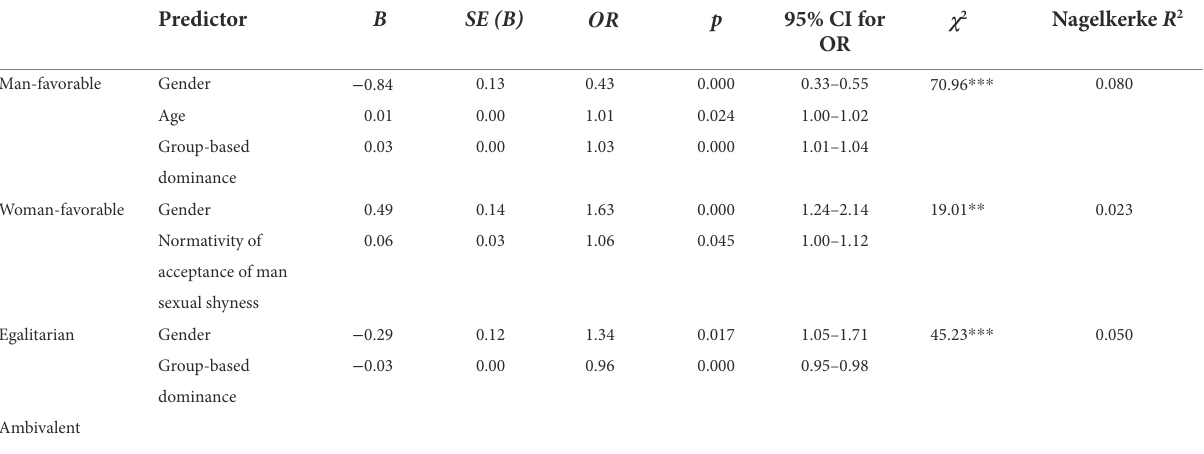
TABLE 7 Hierarchical logistic regressions of predictors of the SDS adherence typologies referring to the sexual shyness